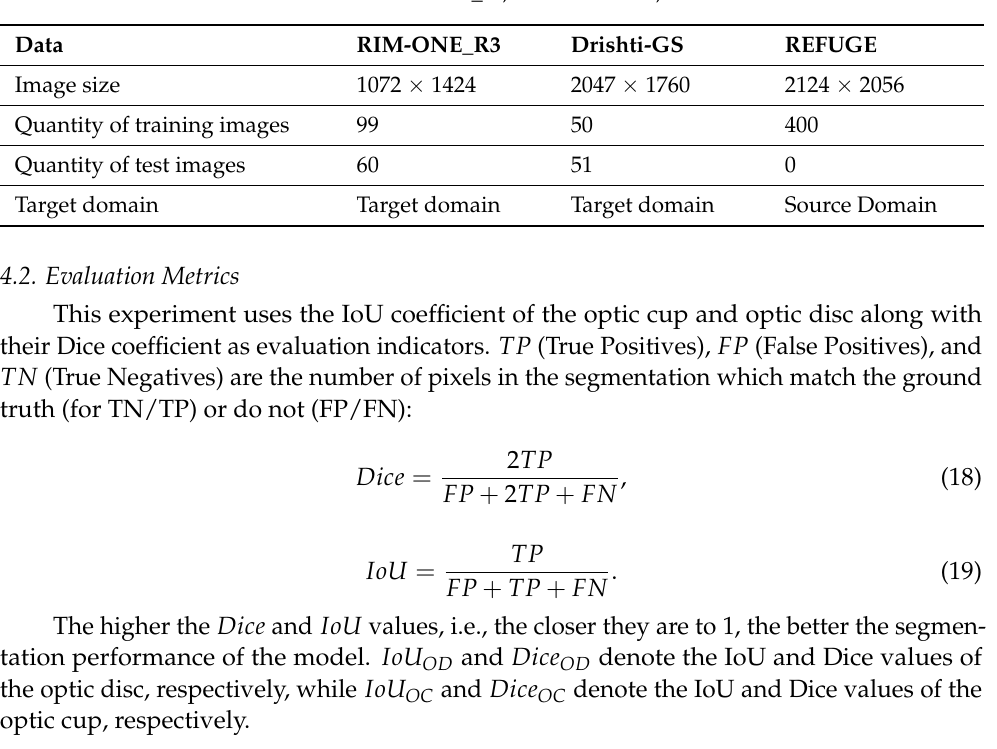
Figure 6. Example fundus images from different datasets. From left to right: REFUGE [50], RIM- ONE_r3 [49], and Drishti-GS [28]. Table 2. Statistical distribution of the RIM-ONE_r3, the Drishti-GS, and REFUGE